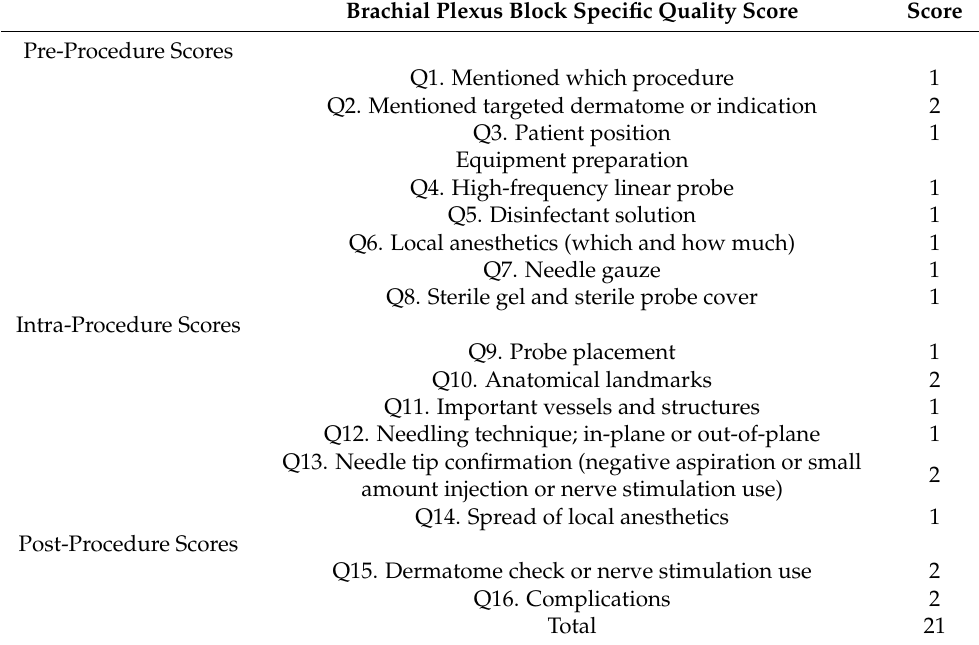
Table 1. Brachial plexus block specific quality